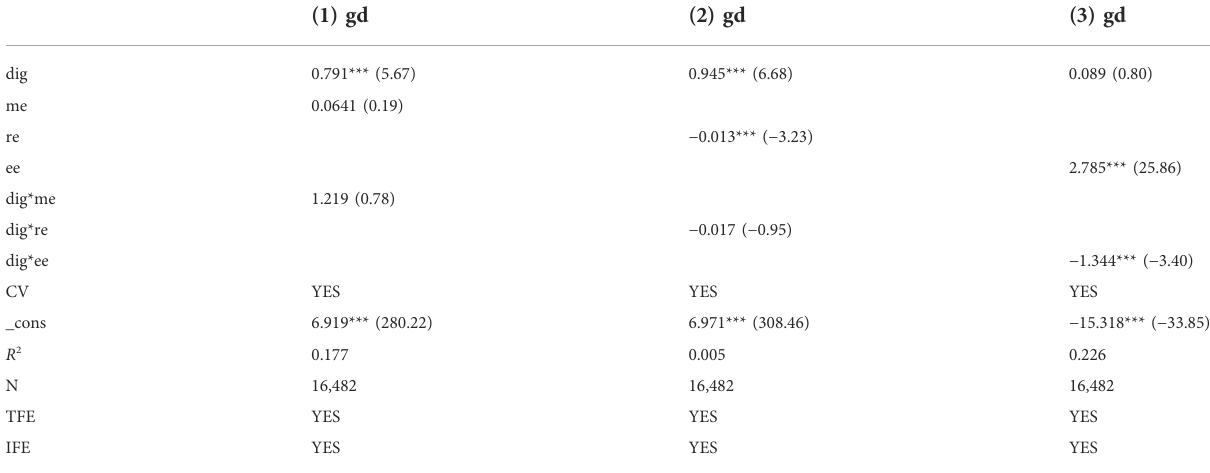
TABLE 5 Moderating effect test